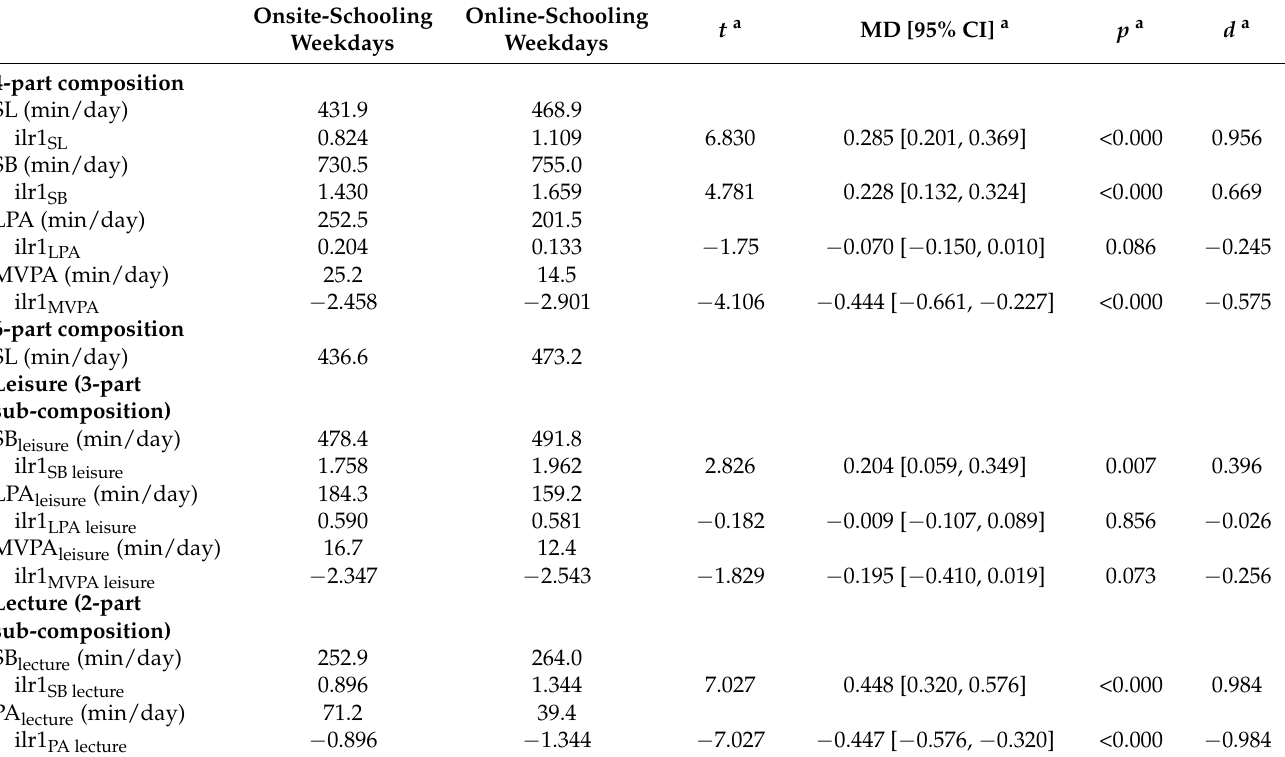
Table 2. Compositional means of movement behaviours within the onsite-schooling and online- schooling condition for a 4-part composition and for a 6-part composition, mean first pivot coordinates (ilr1) for each corresponding compositional/sub-compositional part, and results of the univariable post hoc tests performed on